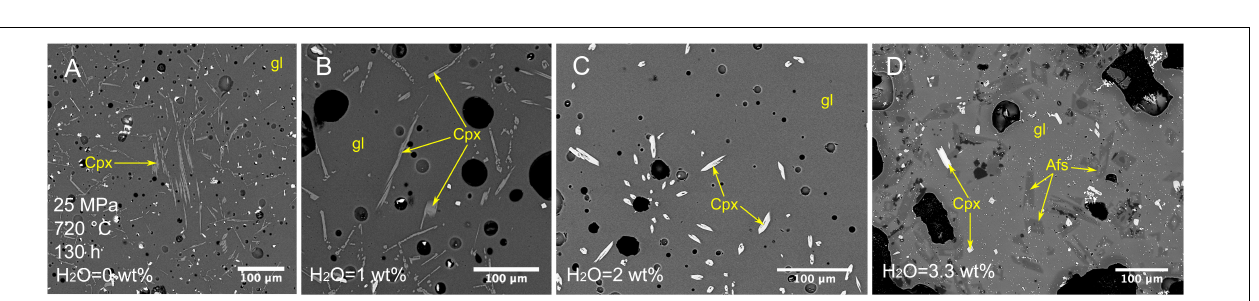
FIGURE 4 | Backscattered SEM images of textures obtained from isobaric cooling experiments at 50 MPa and 720 ◦ C under water-saturated and -undersaturated conditions. Experiments under water-saturated conditions (H 2 O = 4.4 wt.%): (A) Sample C155: experimental duration of 96 h and (cid:49) T = 33 ◦ C; (B) Sample C148: experimental duration of 175 h and (cid:49) T = 33 ◦ C; (C) Sample C149: experimental duration of 195 h and (cid:49) T = 33 ◦ C. Experiments under water-undersaturated conditions (H 2 O = 2 wt.%): (D) Sample C43: experimental duration of 160 h; (E) Sample C49: experimental duration of 220 h; (F) Sample C121: experimental duration of 240 h. Afs, alkali feldspar; Cpx, clinopyroxene; Qz, quartz; gl, glass.